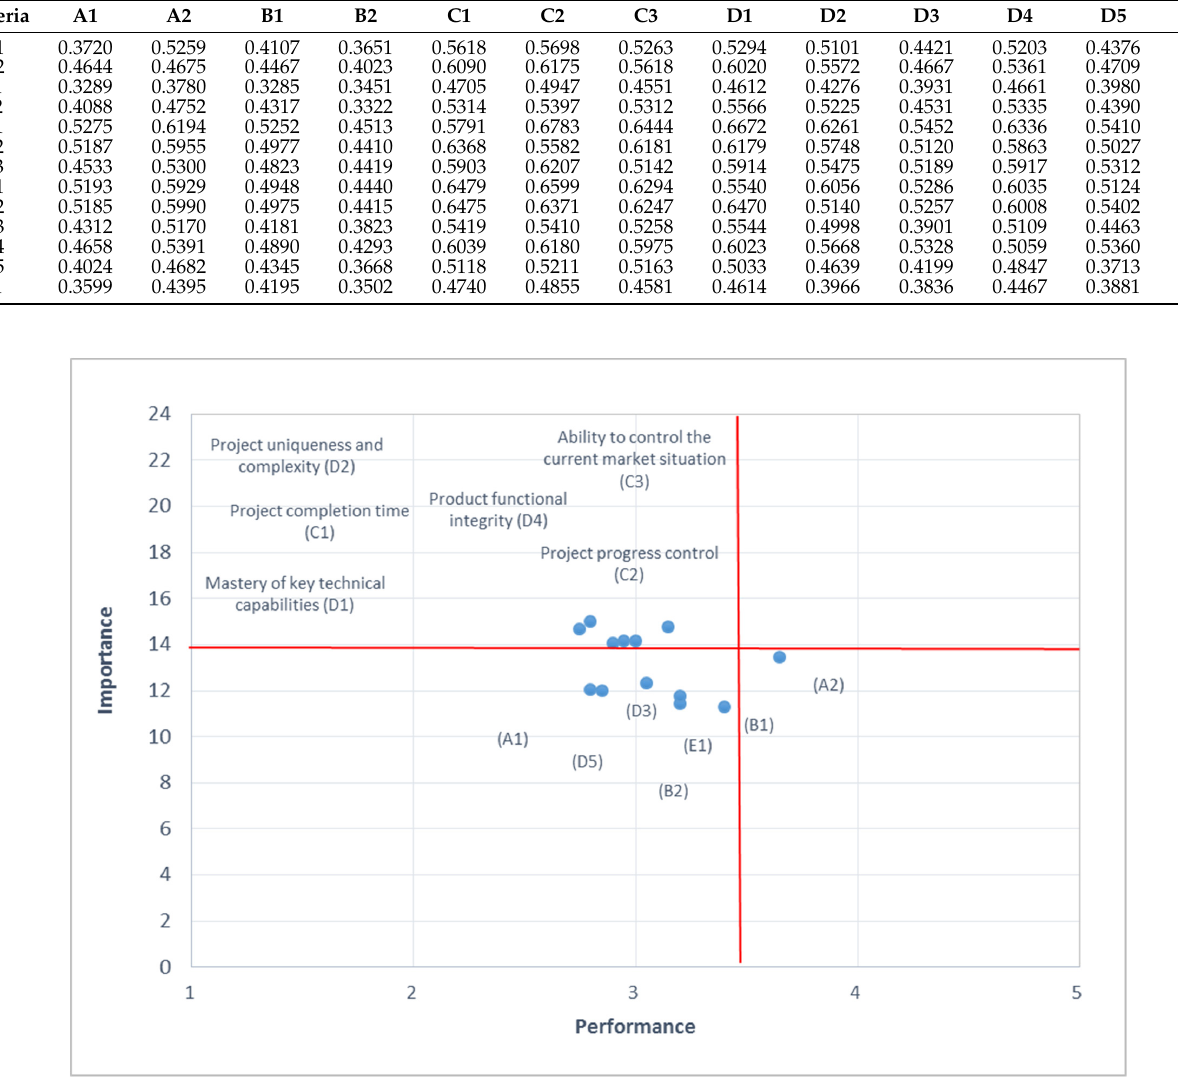
Figure 5. Schematic diagram of the importance of criteria and performance values. Note: (1) The vertical red line represents the threshold value of performance, the left side of the red line represents low performance, and the right side of the red line represents high performance. (2) The horizontal red line represents the threshold value of importance, the upper part of the red line represents high importance, and the lower part of the red line represents low importance. (3) The area of the graph where the standard performance was lower than 3.5 and the importance value was higher than 14 was classified as the “concentrate here” quadrant. (4) The blue dots represent all the criteria.